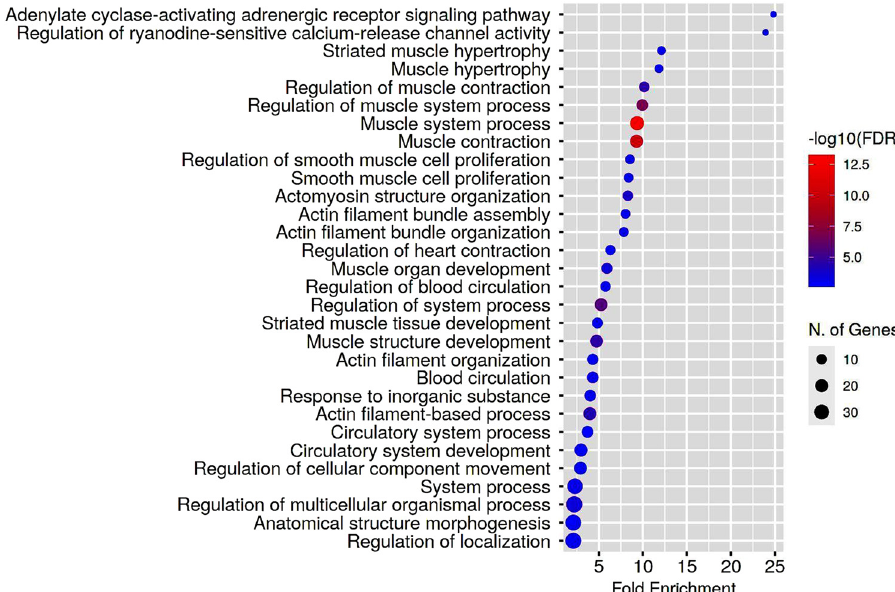
Figure 6: GO enrichment analysis by biological processes for common downregulated DEGs from data set GSE100927. Biological processes are ranked according to the fold enrichment values. The most signi fi cant processes are highlighted in red, and the less signi fi cant ones in blue according to log10 ( FDR ) values. Larger dots in the graph indicate a greater number of genes